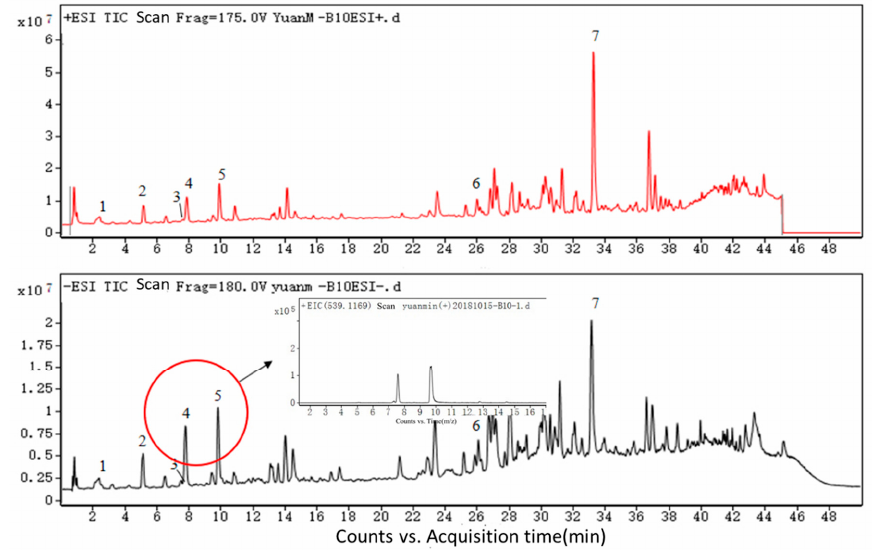
Figure 1. Chlorogenic acid (1), caffeic acid (2), isochlorogenic acid B (3), isochlorogenic acid A (4),